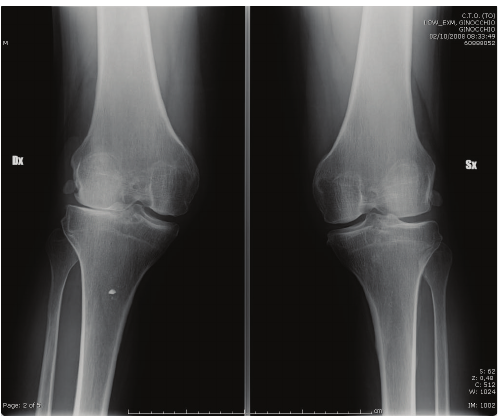
Figure 3: Roentgenograms of bilateral knees in AP, showing later- ally displaced patellae with initial degenerative tibiofemoral arthri- tis.